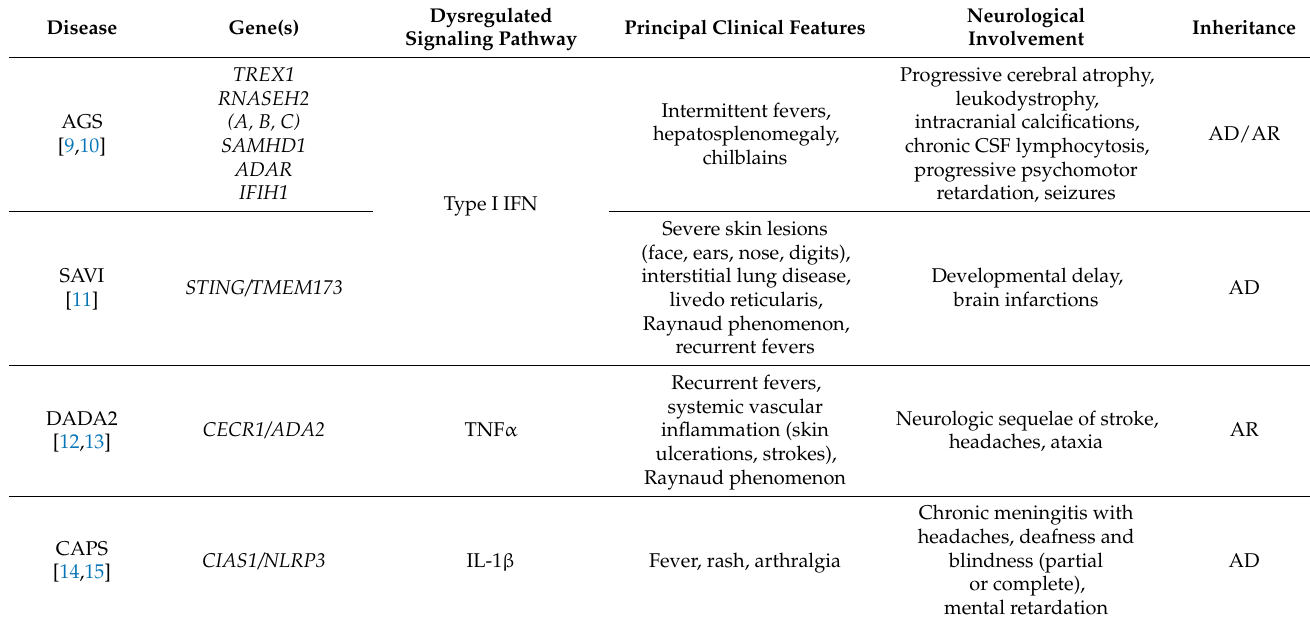
Table 2. Monogenic diseases with immune-mediated involvement of the central nervous